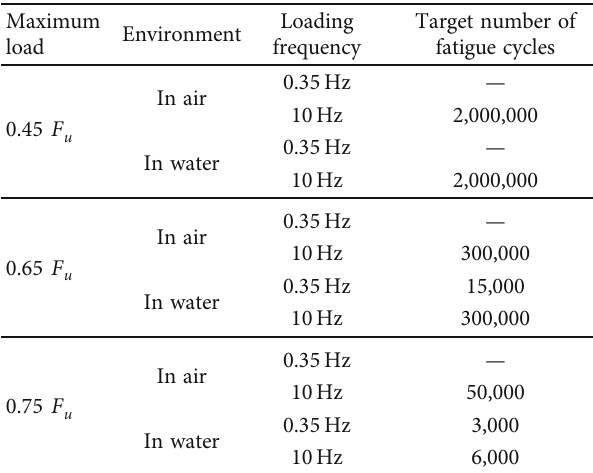
Figure 1: Test rig for the submerged fatigue tests. Table 1: Combinations of test parameters and target numbers of fatigue